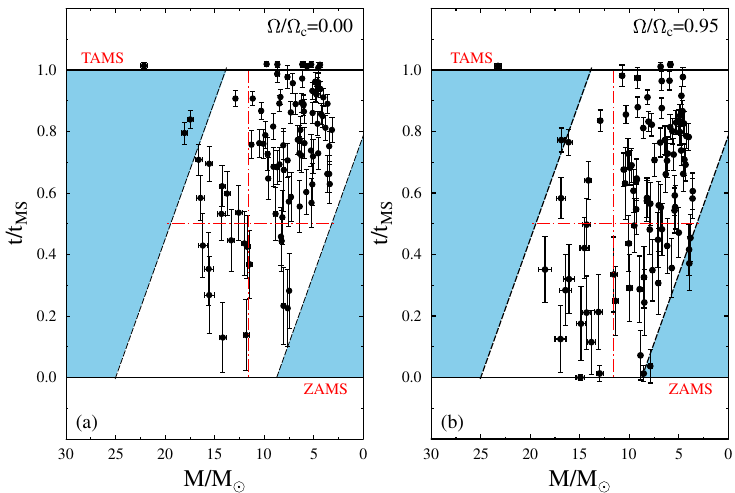
Figure 35. Age ratios t / t MS against the mass of Be stars studied in Zorec et al. [61]. ( a ) Parameters derived using evolutionary tracks without rotation; and ( b ) parameters derived using evolutionary tracks with rotation. Adapted from Zorec et al.